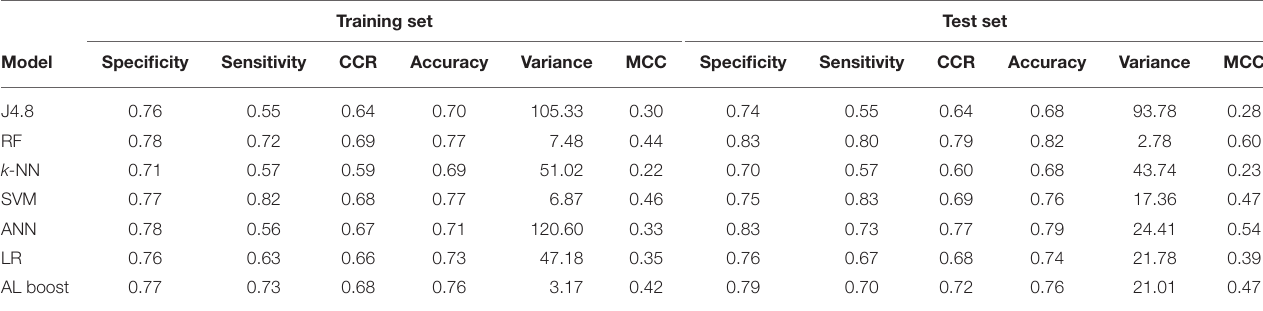
TABLE 7 | Classification results of cardiovascular drugs vs. nervous system drugs, where specificity represents the nervous system and sensitivity represents the cardiovascular drugs. Training